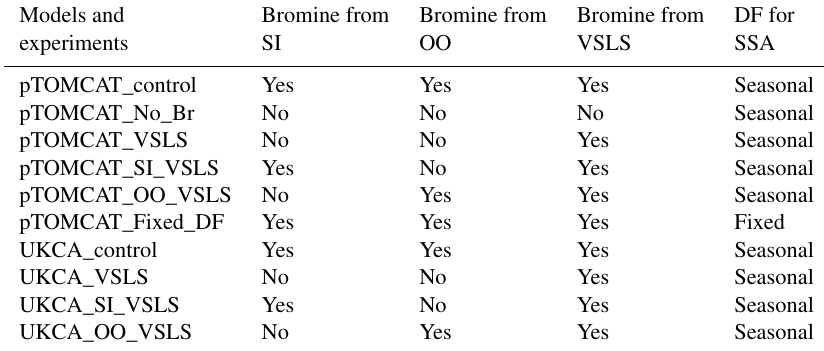
Table 2. Model experiments with various bromine sources from sea ice (SI), open ocean (OO), and very-short-lived substances (VSLSs) of bromocarbons. Two bromine depletion factor (DF) schemes are used: with seasonal cycle (Table 1) and without seasonal cycle (i.e. using a fixed DF in Table S1). Models and Bromine